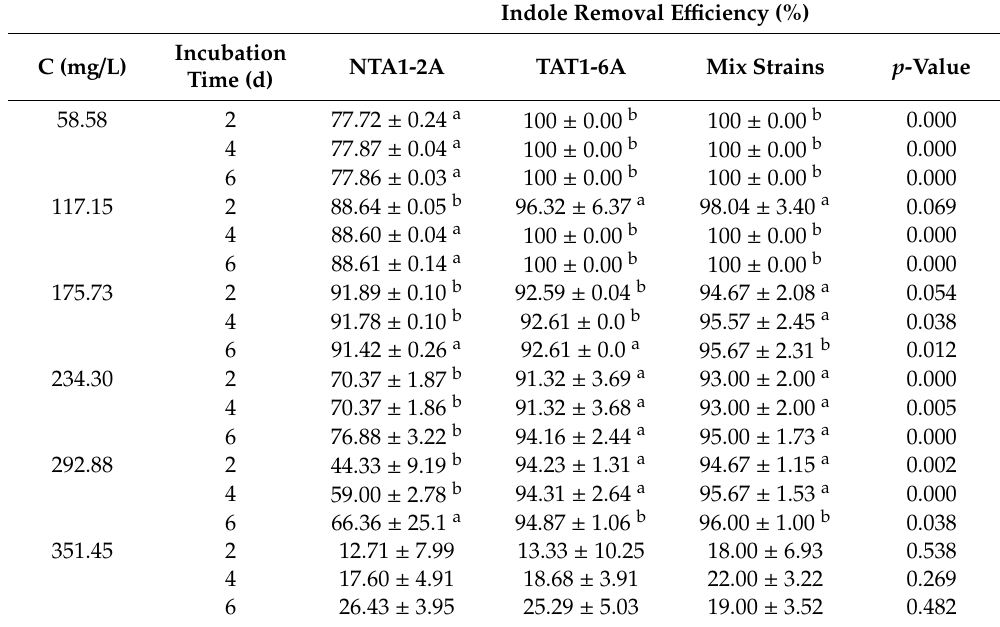
Table 1. Indole degradation ability of NTA1-2A, TAT1-6A, and a mix incubated for 6 days. Values are the mean ± SD of triplicate